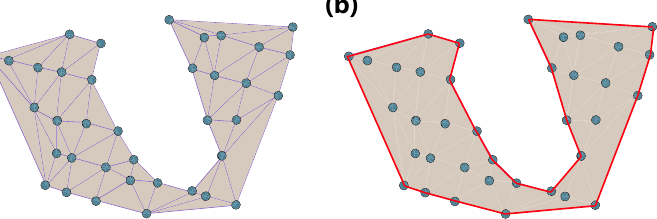
Figure 8. Triangulation generation and boundary extraction of sparse point cloud based on pro- posed algorithm: ( a ) represents triangular mesh generation; ( b ) represents boundary